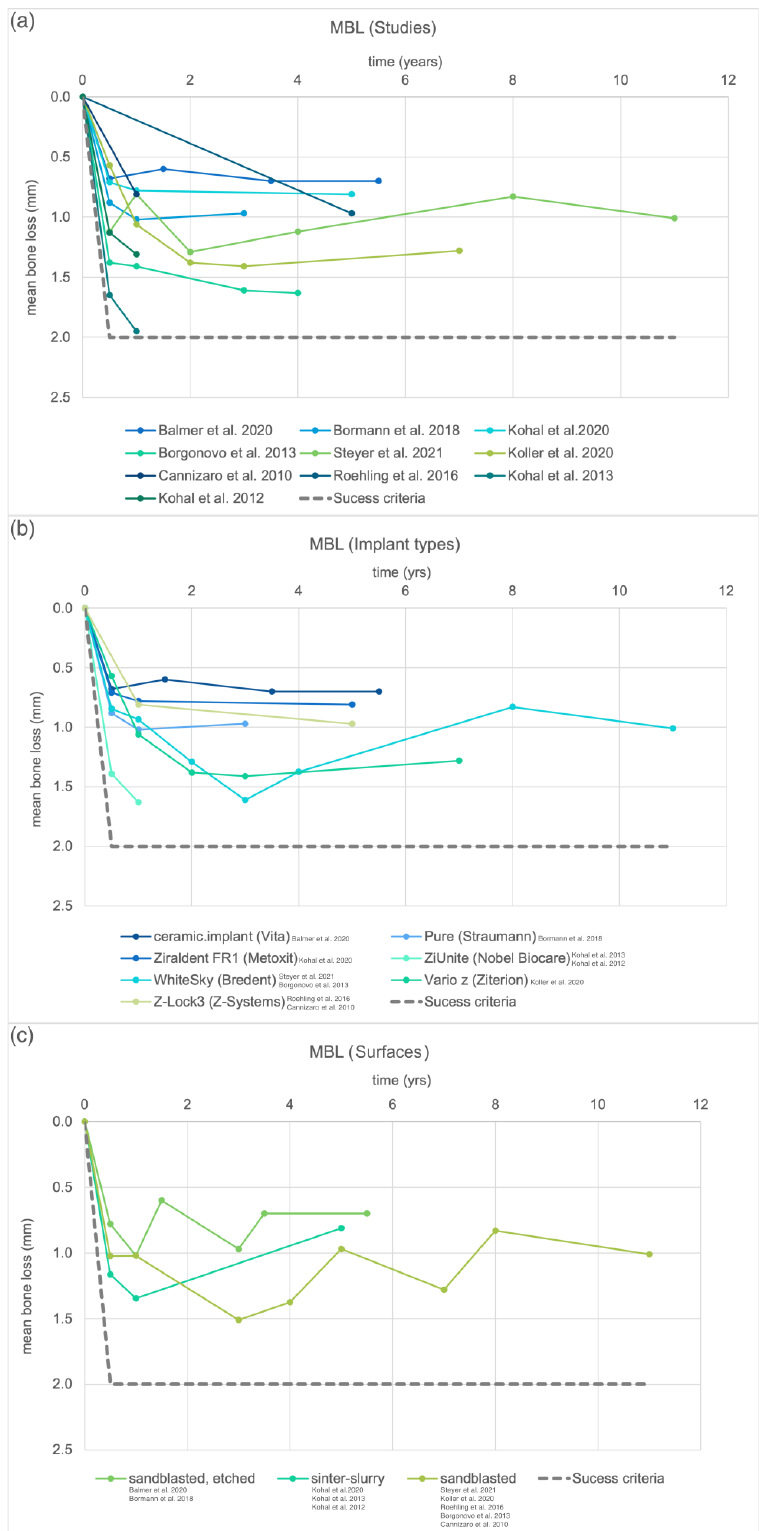
Figure 2. Mean bone loss (MBL) reported in clinical studies with zirconia implants at the respective follow-up. The threshold value included as success criteria was defined by Misch et al. 2008 [34]. ( a ) Mean bone loss of all included clinical trials, ( b ) mean bone loss pooled by implant type and ( c ) mean bone loss pooled by implant surface